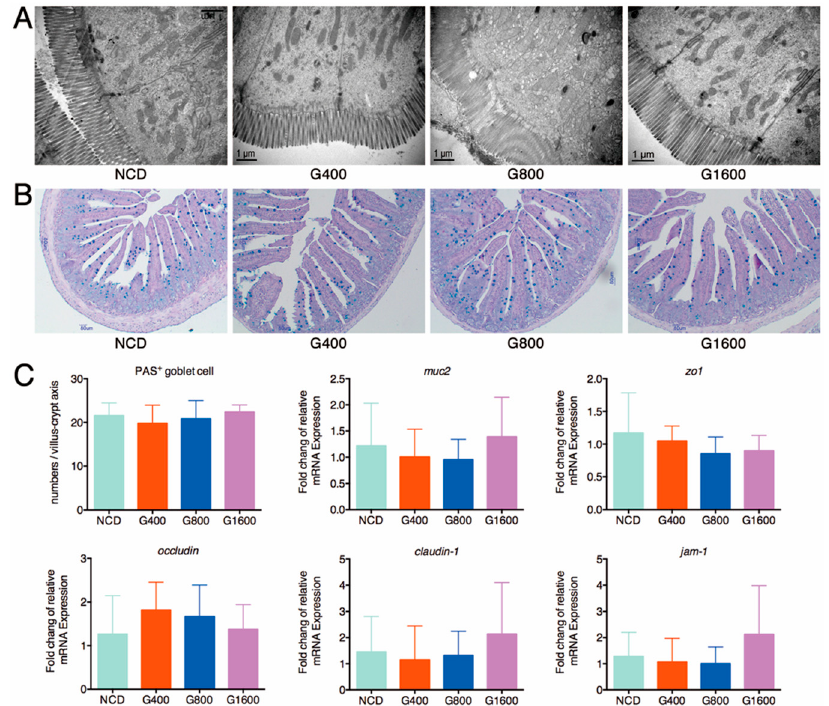
Figure 2. E ff ect of di ff erent doses of GML on the intestinal barrier function. ( A ) TEM analysis of the jejunum section, ( B ) AB / PAS staining of jejunum to define the secretion of mucus of goblet cells, ( C ) The mRNA levels of di ff erent genes ( muc2 , zo1 , occludin , claudin-1 and jam-1 ) in the distal ileum measured using qRT-PCR and normalized to the β -actin mRNA expression. Data were expressed as mean ± SD ( n = 6–8).